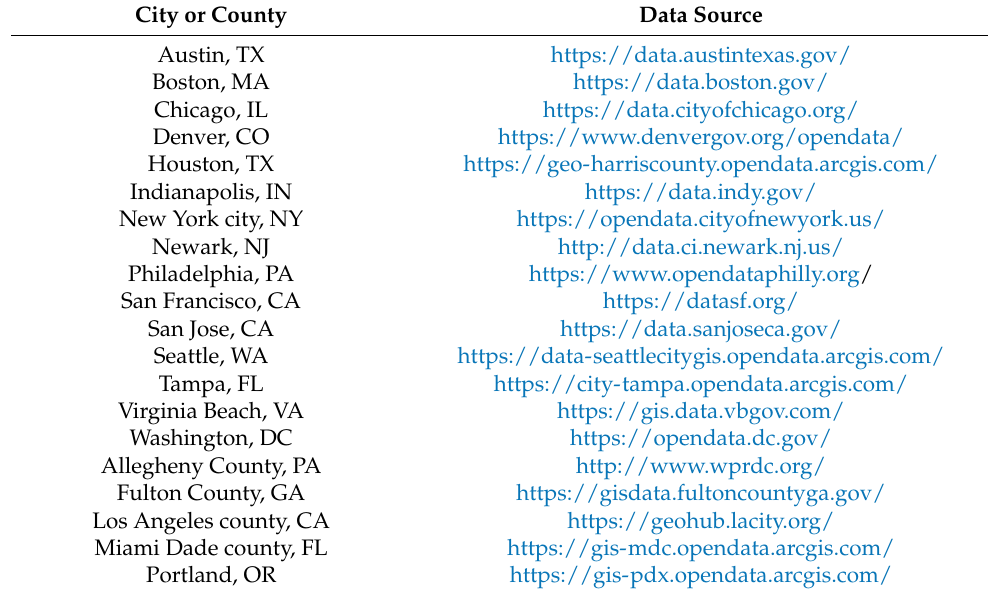
Table A1. Sources of used GIS files. The datasets were downloaded from these sources